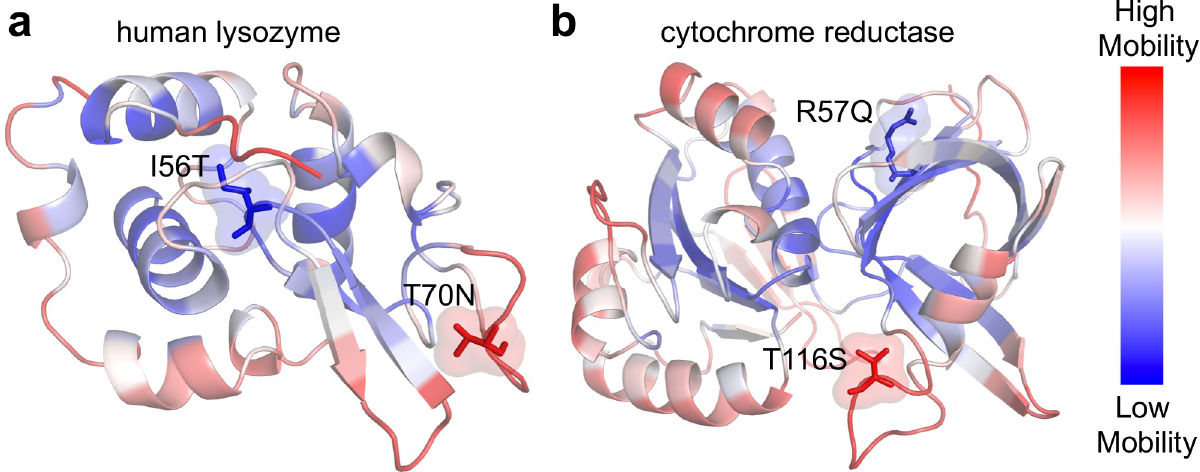
Fig 6. Comparison of theoretical B-factors on disease versus neutral mutant sites. A ribbon diagram for two human enzymes, human lysozyme (a) and cytochrome reductase (b) colored according to their predicted B-factors by the Seq-GNM. Red indicates high mobility sites, and blue indicates low mobility sites. Each protein contains two known nSNVs. I56T and R57Q are disease-associated, and they occur on low mobility (rigid) sites. Conversely, the neutral nSNVs T116S and T70N occur on high mobility sites.